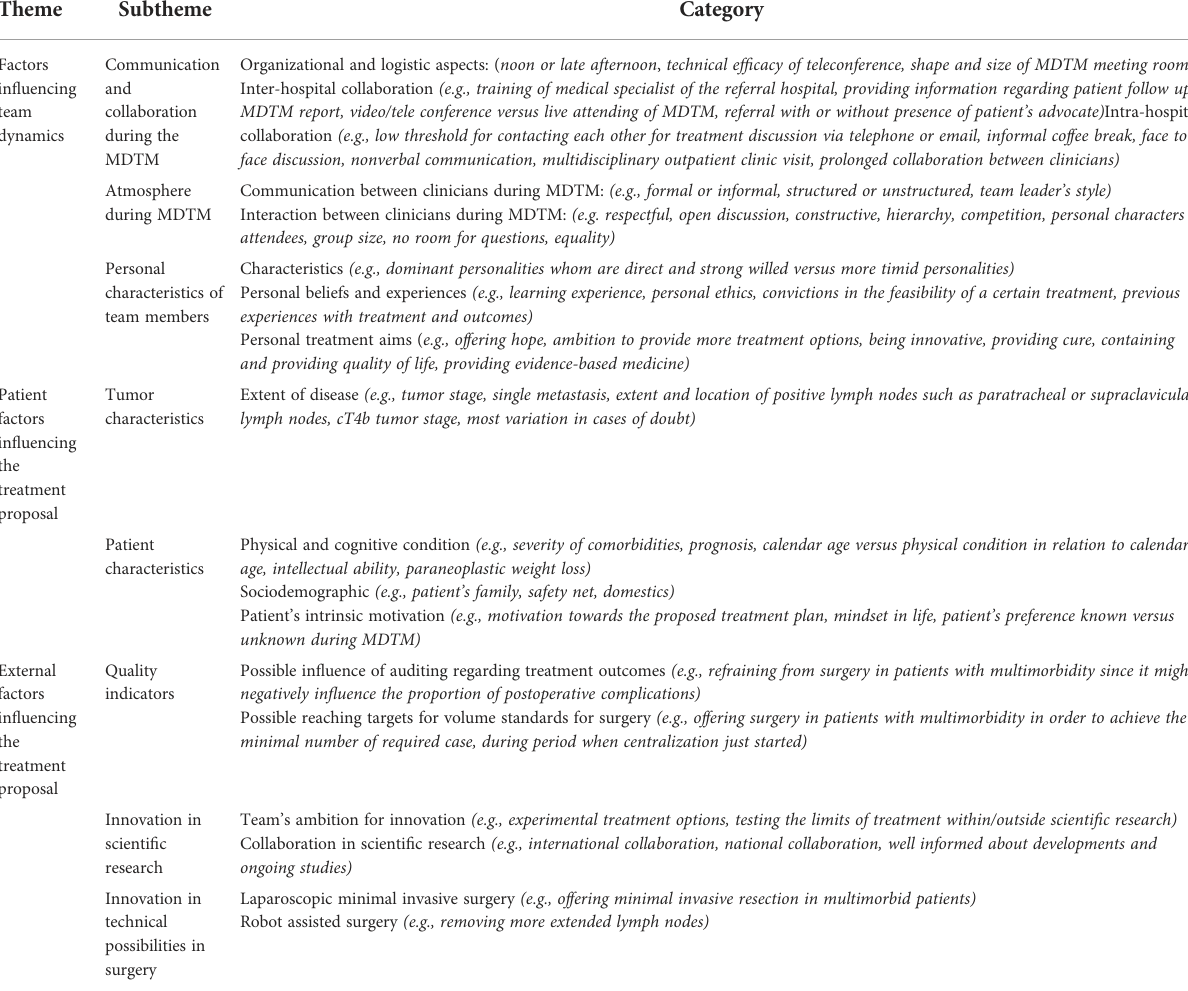
TABLE 1 Barriers and facilitators associated with CDM during an oncologic Upper-GI MDTM Figure 1